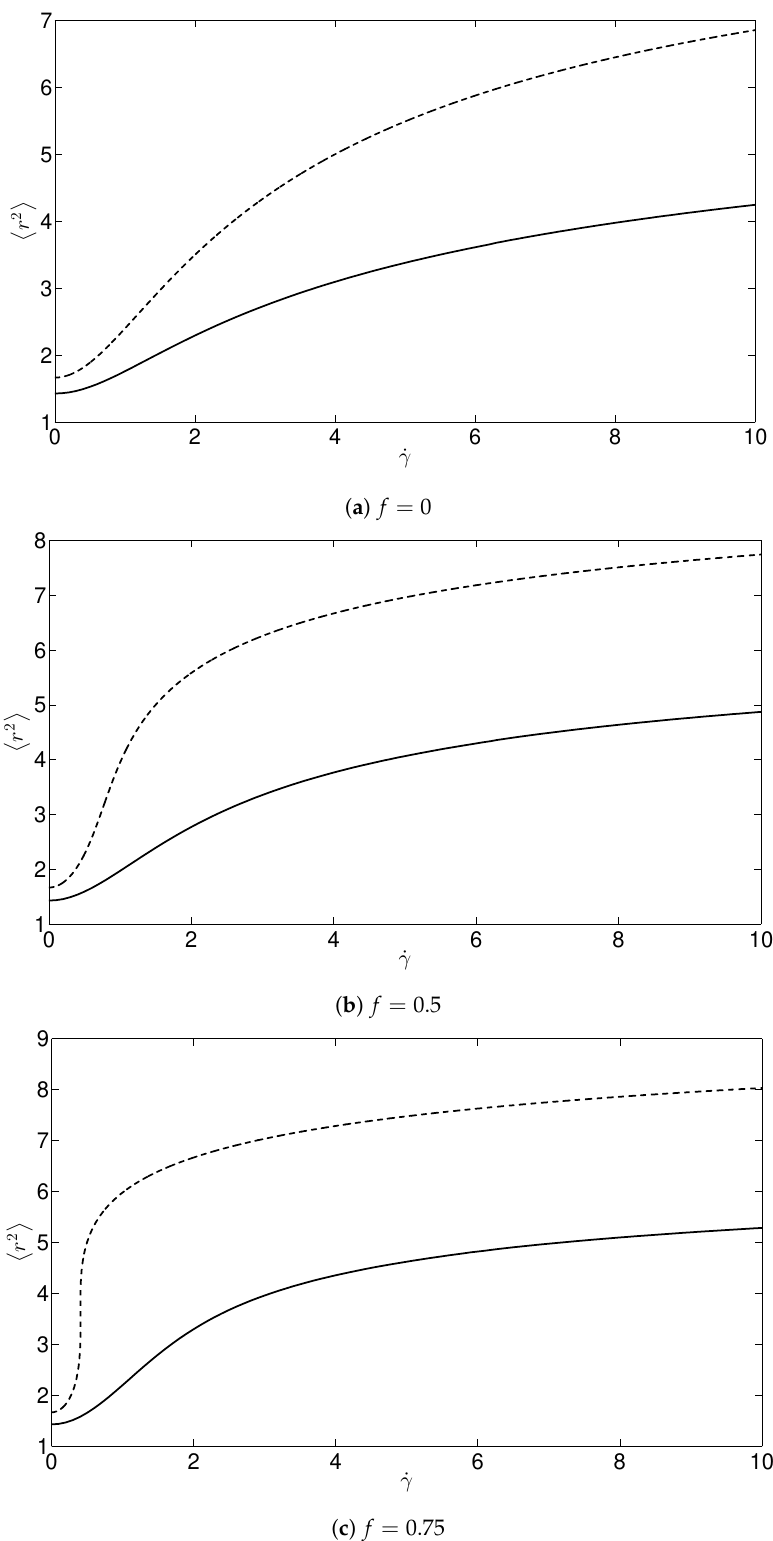
(cid:10) (cid:11) r 2 plotted against the non-dimensional